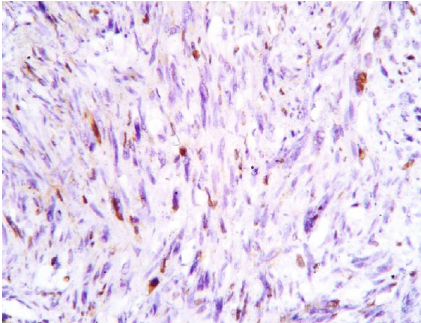
Figure 6: Poorly di ff erentiated malignant mesenchymal tumor. Immunohistochemistry assay with Ki-67 antibodies.